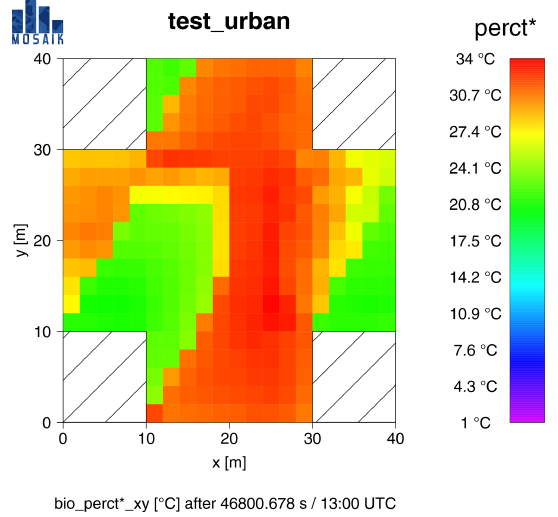
Figure 5. PT (perct ∗ in PALM) for the test case “test_urban” at 13:00UTC (close to midday) on 6 March. Incident wind is from 270 ◦ with 1.0ms − 1